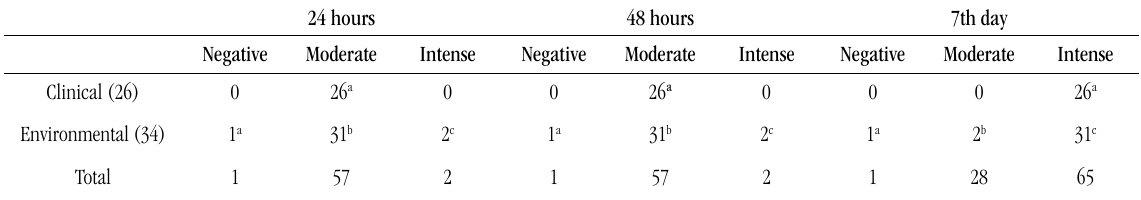
tABLE 7 – Urease production activity in clinical and environmental Cryptococcus neoformans samples isolated in Sergipe,